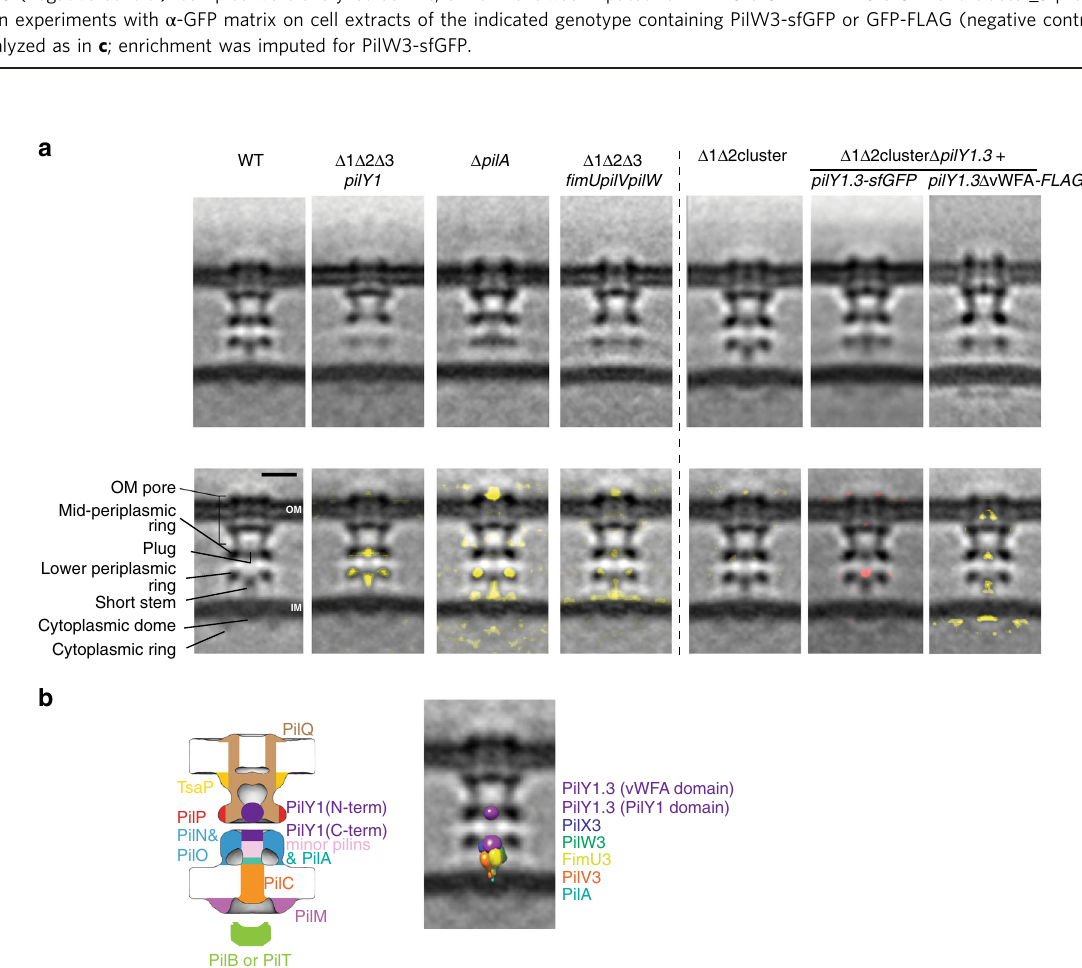
Fig. 4 PilA, minor pilins, and PilY1 make up the short stem and plug. a Structures (subtomogram averages) of T4aPM in strains of the indicated genotypes. Top row, central slices through subtomogram averages of empty T4aPM. Lower row, fi rst panel describes densities observed in subtomogram average of empty WT T4aPM (see also Fig. 1a) as described in ref. 3 , panels 2 – 5 show differences between T4aPM in mutants versus the WT (lacking densities, yellow), and panels 6 and 7 the difference between T4aPM in SA7791 ( Δ 1 Δ 2cluster Δ pilY1.3 + PilY1.3-sfGFP) and SA8764 ( Δ 1 Δ 2cluster Δ pilY1.3 + PilY1.3 Δ vWFA-FLAG) versus T4aPM in Δ 1 Δ 2cluster structure (lacking densities, yellow; extra density, red). Panels 1, 3, and 4 in both rows are from ref. 3 (reprinted with permission from AAAS). Scale bar, 10 nm. b Model of T4aPM priming complex. Panel 1, component map of non-piliated T4aPM with priming complex and proteins assigned to the densities in the subtomogram average of the non-piliated WT T4aPM; for simplicity, PilB and PilT are not shown separately. Panel 2, hypothetical structural model of priming complex after low-pass fi ltering to 3-nm resolution and placed into the subtomogram average of non-piliated WT separated by regions of unde fi ned structure (Supplementary a strategy that previously allowed us to map other core proteins Figs. 2a, c and 3b), we therefore hypothesized that one PilY1.3 (PilP and PilO) in the T4aPM subtomogram averages 3 . domain could make up the uppermost part of the short stem close of which exclusively expressed untagged PilY1.3 and the other to the lower periplasmic ring and the second domain could account for the plug density. To test this hypothesis, we fi rst used